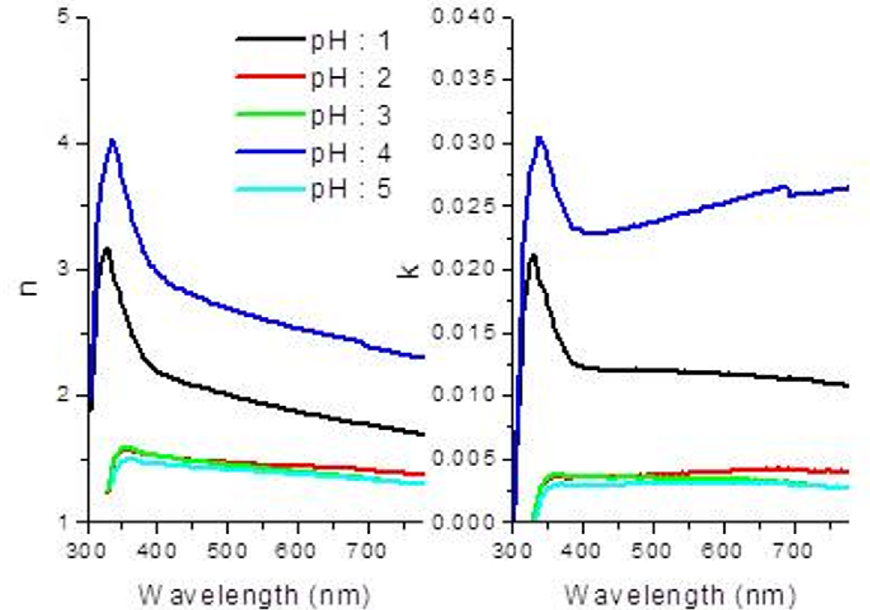
thin films produced at different pH. x